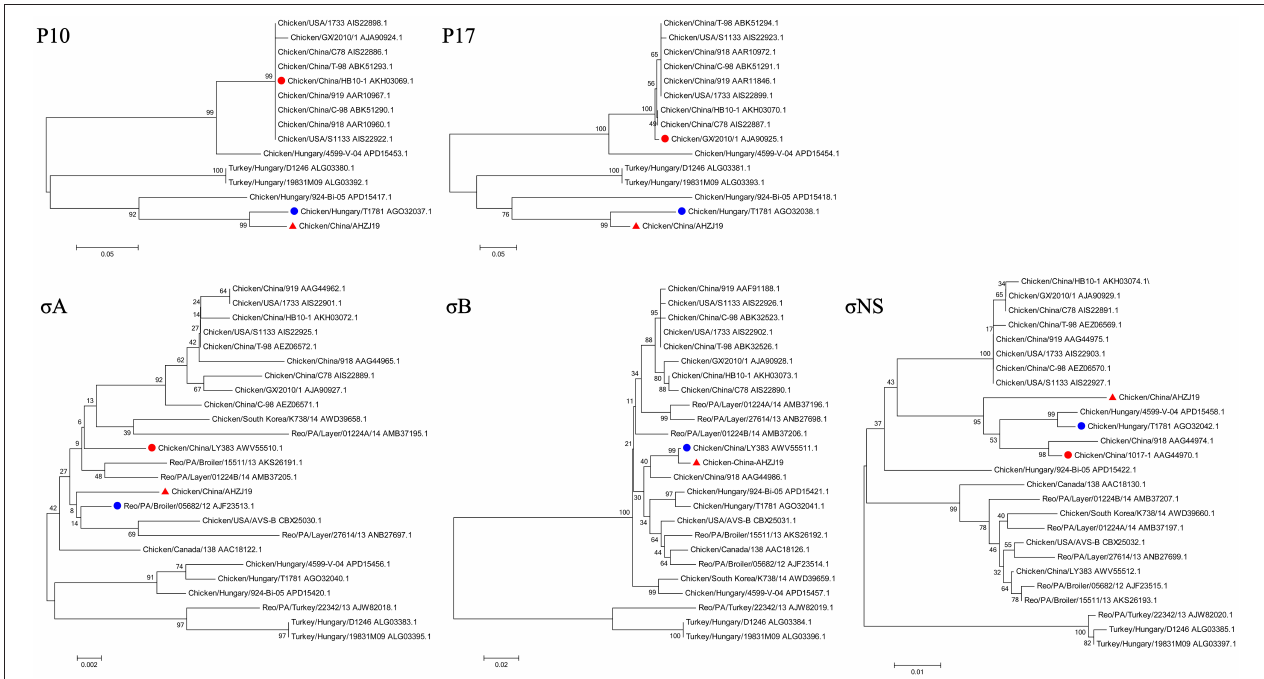
FIGURE 4 | Phylogenetic trees of AHZJ19 and reference strains based on aa sequences of P10, P17, σ A, σ B, and σ NS proteins. The phylogenetic tree was constructed using the neighbor-joining method (1,000 bootstraps) with MEGA6. The AHZJ19 strain isolated in Anhui in 2019 is indicated by the red triangle. The strain sharing the highest homology with AHZJ19 in the world and in China is indicated by the blue and red circle,